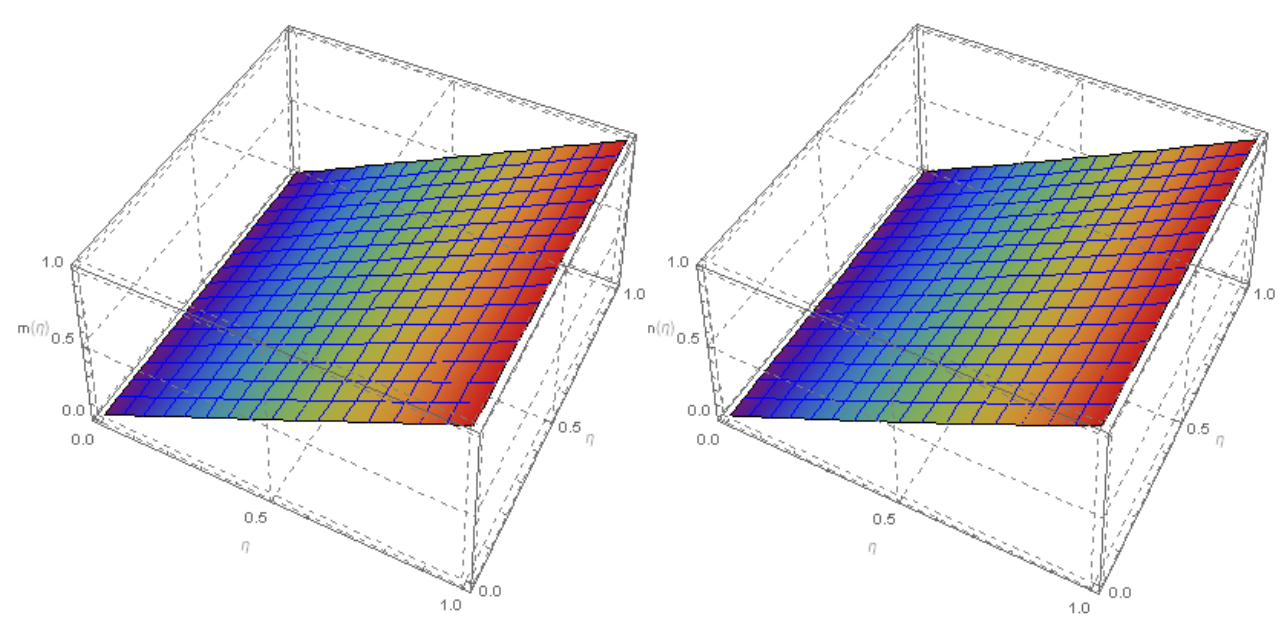
Figure 4. 3D graph for f ( η ) , g ( η ) , m ( η ) , and n ( η ) with S z = − 0.1, M x = 0.1, M y = 0.3, R m = 0.01, and S = 1.